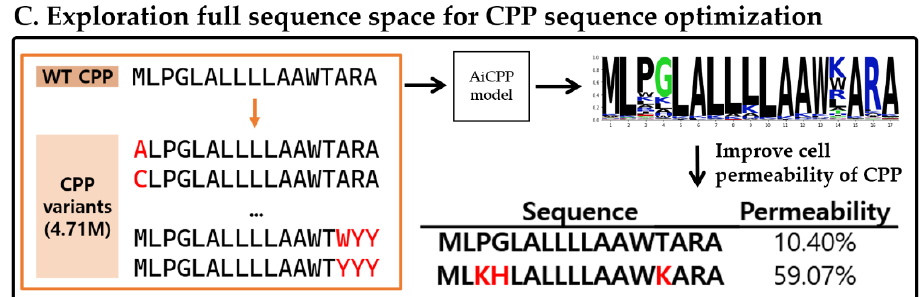
Figure 1. Schematic workflow of the AiCPP, showing ( A ) training the AiCPP model, ( B ) identifica- tion of the CPP region in the APP protein, and ( C ) exploration of full sequence space for CPP se- quence optimization.